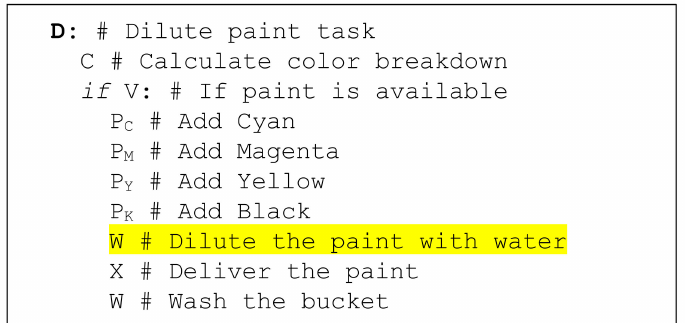
Figure 6. Pseudocode for the Dilute Paint task (D) with additional step